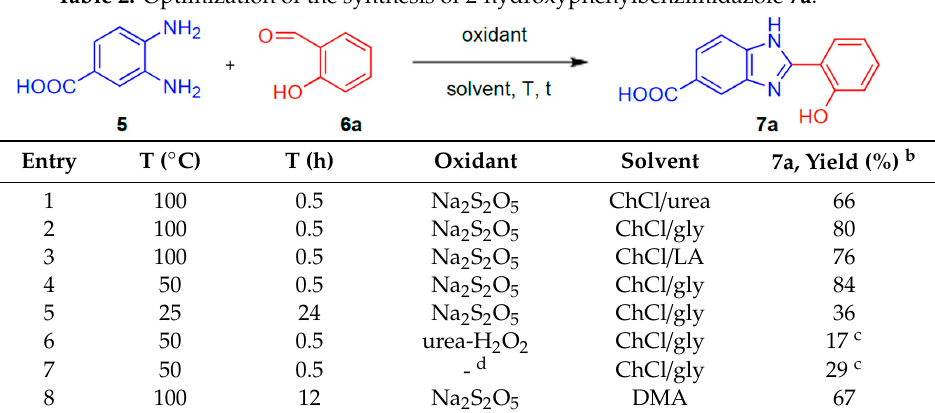
Table 2. Optimization of the synthesis of 2-hydroxyphenylbenzimidazole 7a . a